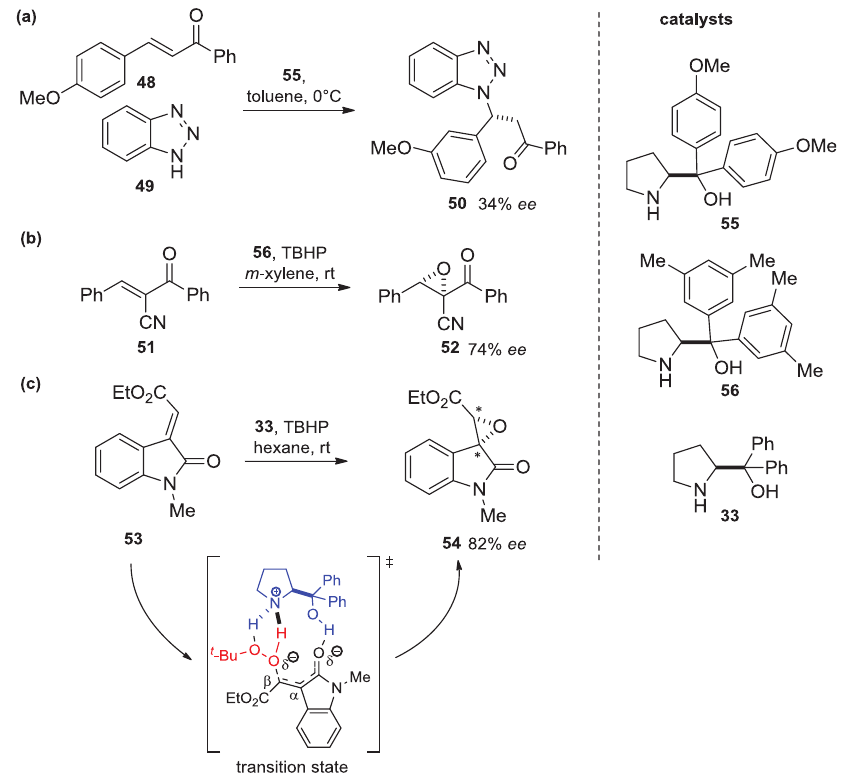
Figure 14. Enantioselective conjugate addition of N-heterocycles to α , β -enones (a), from Ref. [67]; epoxidation of acrylonitriles (b), from Ref. [69]; epoxidation of α -ylidenoxindoles (c), from Ref.